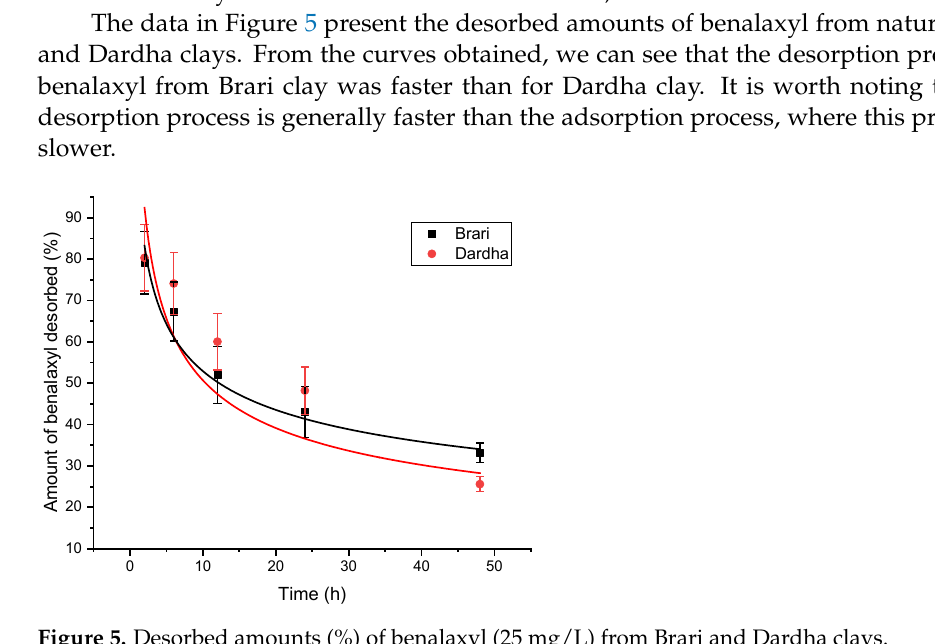
clay held less adsorbed pesticide than Dardha